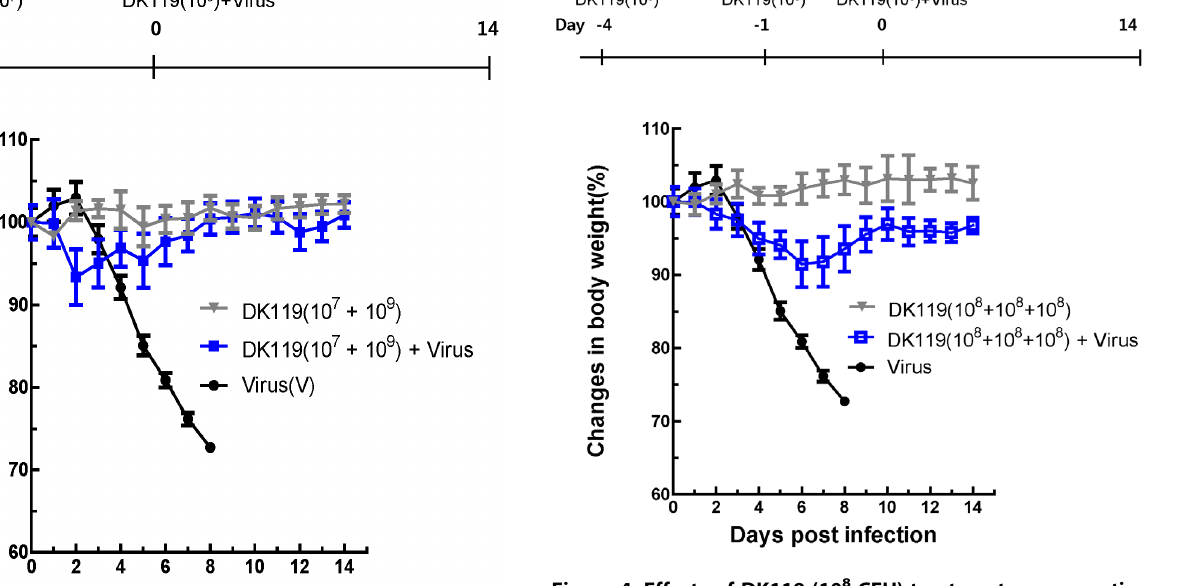
Figure 4. Effects of DK119 (10 8 CFU) treatment on preventing weight loss against influenza H1N1 virus infection. A group of mice (n=6) was treated with DK119 (10 8 CFU/mouse) at 4 days and 1 day prior to infection with A/PR8 virus (2.5 LD 50 ) in the presence of a low dose of DK119 (10 8 CFU per mouse). Virus(V): mice infected with A/ PR8 virus, DK119 (10 8 + 10 8 + 10 8 ) + V: mice pretreated twice with DK119 and infected A/PR8 H1N1 virus in the presence of with DK119 (10 8 CFU per mouse). Bars indicate standard errors.DK119 (10 8 + 10 8 + 10 8 ): mice treated with DK119 alone (10 8 CFU/mouse at 3 different time points without virus infection).